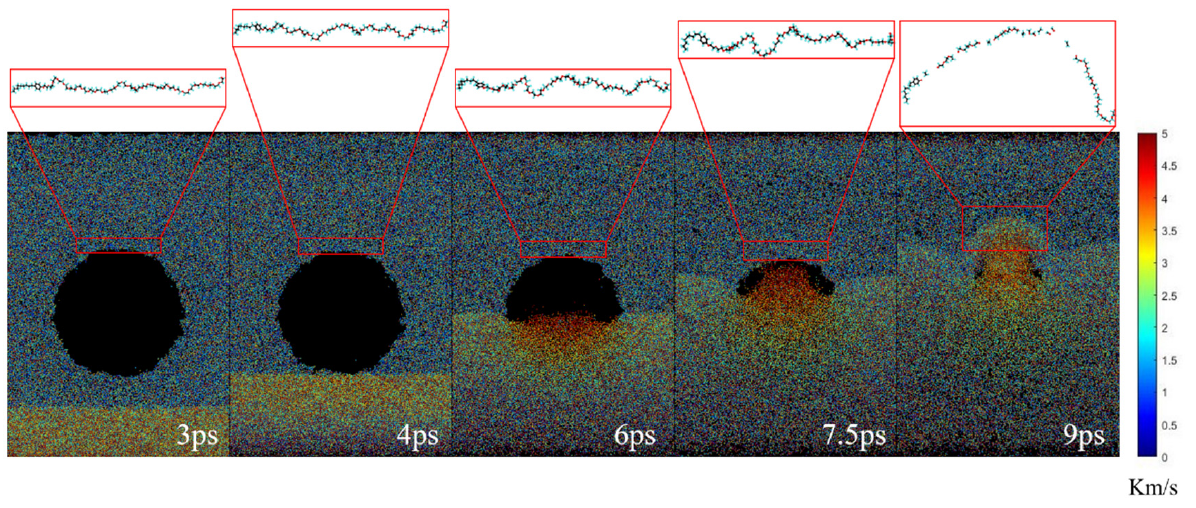
Figure 2. The time evolution of the vacuum nanobubble system under the action of exerted shock wave. The corresponding morphologies of the NP30EOs at the given simulation time are particularly shown on the top of each configuration.